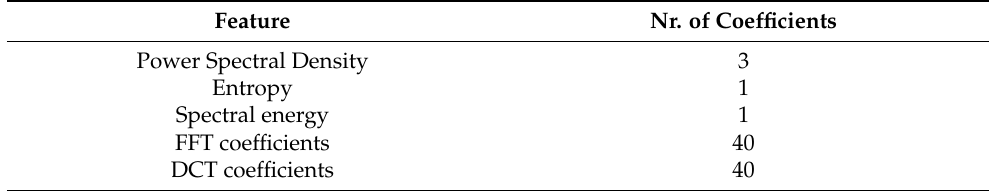
Table 3. Frequency-domain